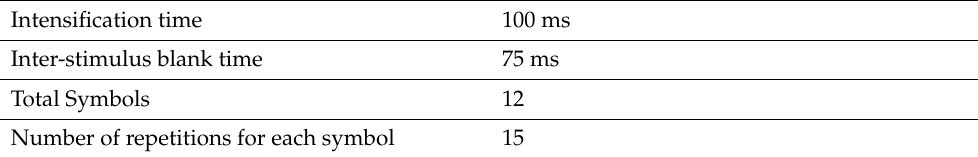
Table 1. Flashing time of the proposed paradigm. Intensification time 100 ms Inter-stimulus blank time 75 ms Total Symbols 12 Number of repetitions for each